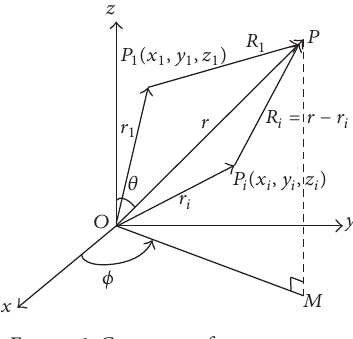
Figure 1: Geometry of array antenna.